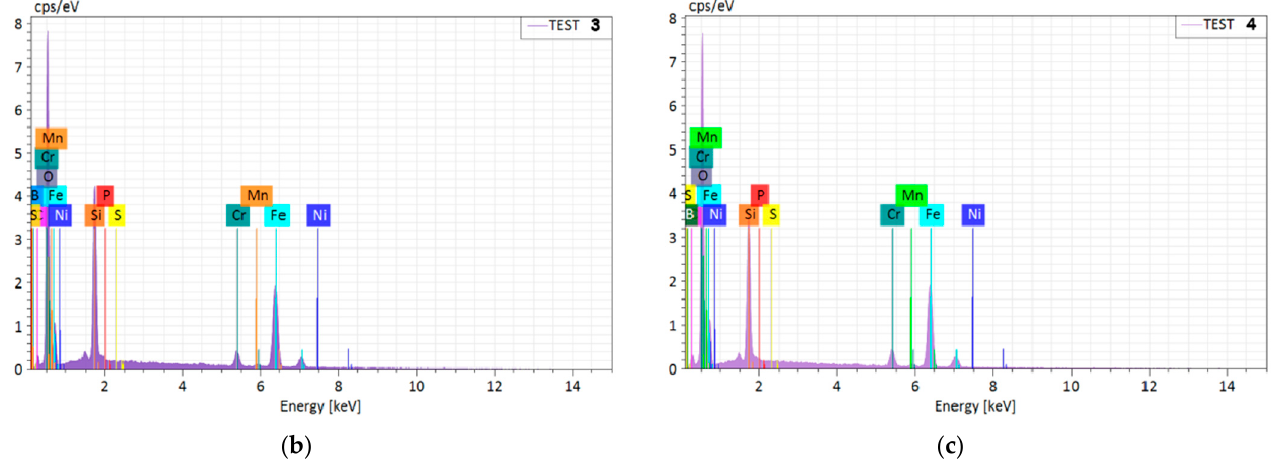
Figure 14. Fe-based EDS spot scan. ( a ) The image of Ni-based interface at 200 μ m of the scale; ( b ) The EDS image of Test 3; ( c ) The EDS image of Test 4. Table 9. Fe-based EDS spot scan of atoms for each element content (wt%).